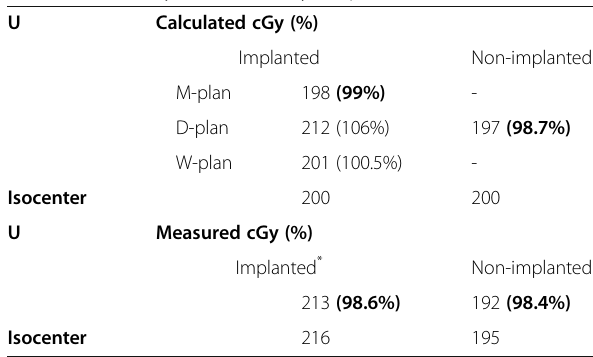
Table 1 Absolute and relative (percentage) calculated and measured dose by film dosimetry for point U